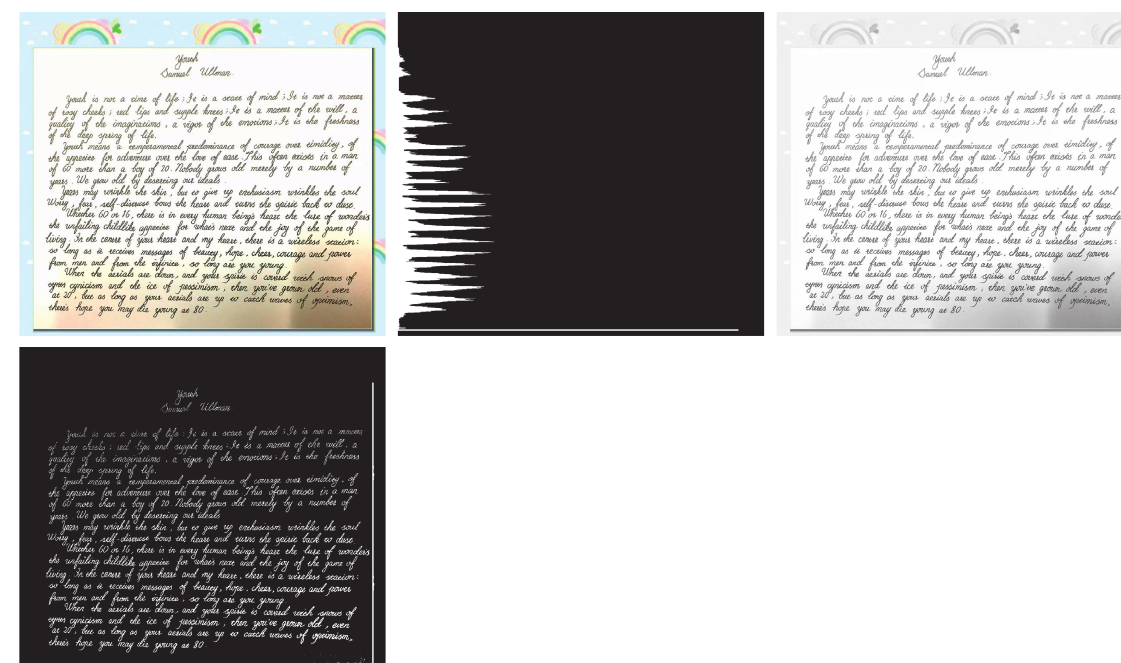
Figure 7: Example of image description